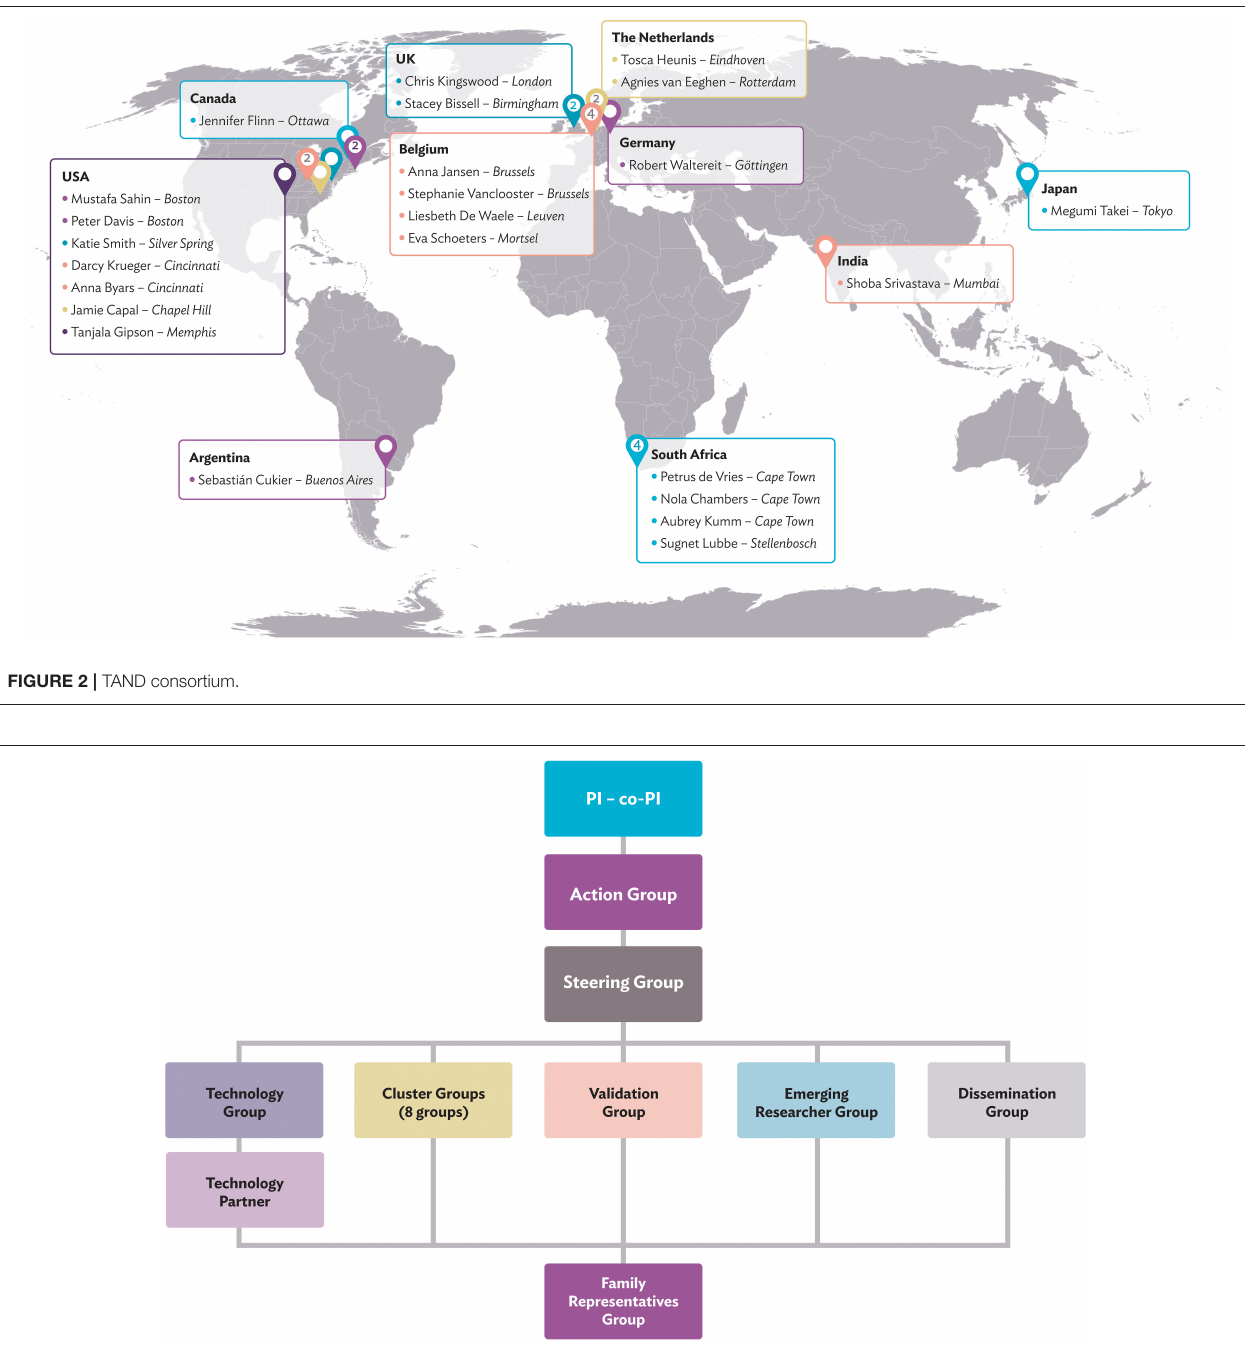
FIGURE 3 | TAND consortium working groups. PI, principal investigator; Co-PI, Co-principal investigator.